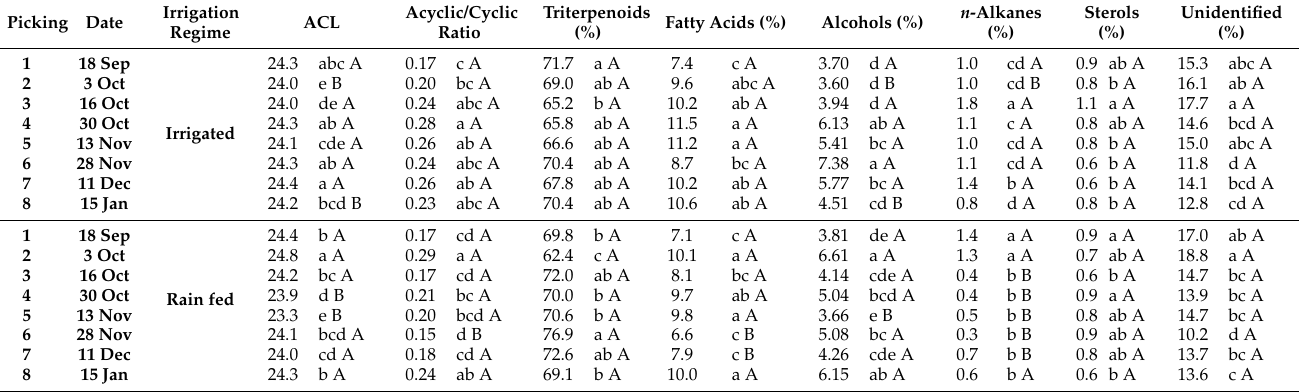
Table 4. Composition of wax constituents (relative % over total waxes) in fruit cuticles isolated during ripening of irrigated and non-irrigated ‘Arbequina’